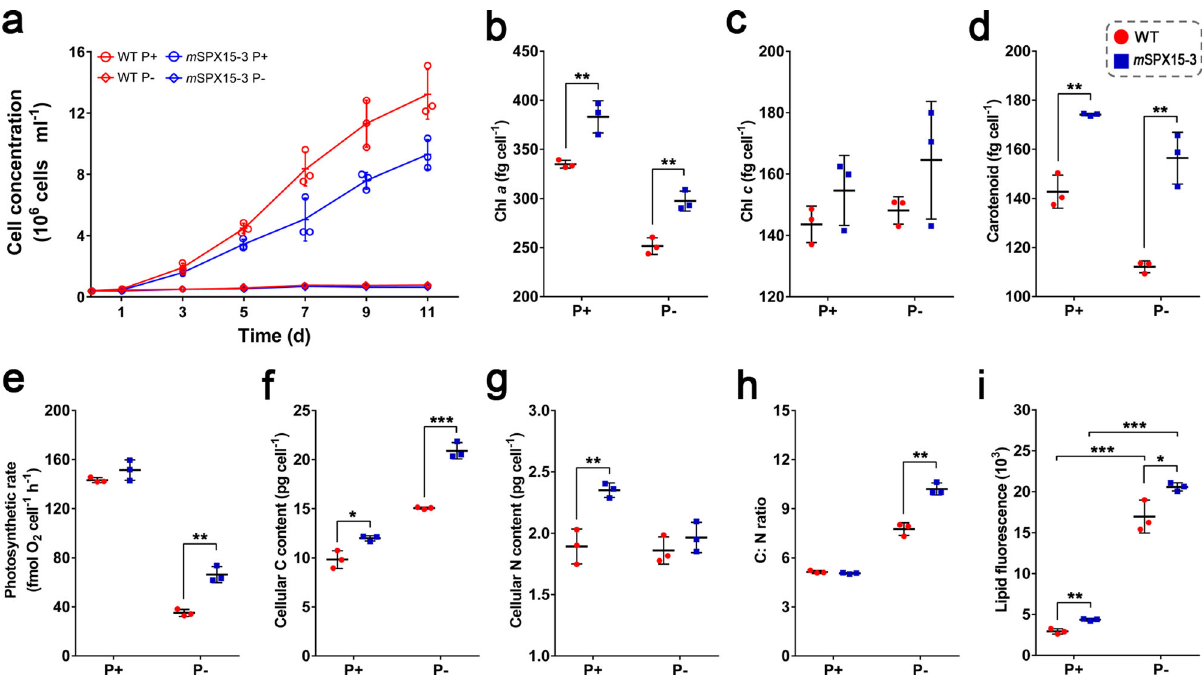
Fig. 2 The physiological responses after SPX inactivation in P. tricornutum under different P conditions. WT and m SPX15-3 strains were cultured in normal (P + ) and P-de fi cient (P − ) media. a growth curve; b chlorophyll a content; c chlorophyll c content; d carotenoid content; e photosynthetic rate; f cellular carbon content; g cellular nitrogen content; h cellular C: N ratio; i the intensity of neutral lipid BODIPY-stain fl uorescence as measured by fl ow cytometry. Data are from day 3 of the (P + ) or (P − ) WT and m SPX15-3 cultures ( n = 3). Error bars, SD. Asterisks indicate a signi fi cant difference, * p value < 0.05, ** p value < 0.01, and *** p value < 0.001, ANOVA